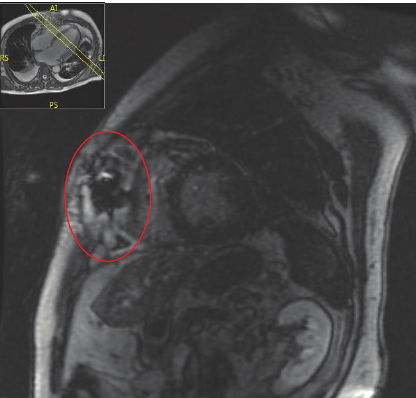
Figure 1: Cardiac MRI (short axis view) demonstrates findings consistent with sternal osteomyelitis, as evidenced by abnormal pericardial thickening and enhancement contiguous with a 1.5cm fluid collection at the inferior margin of the sternotomy (red oval). Inset at top left illustrates plane of cross-sectional image (AI = anteroinferior, LI = left inferior, RS = right superior, and PS = posterosuperior).